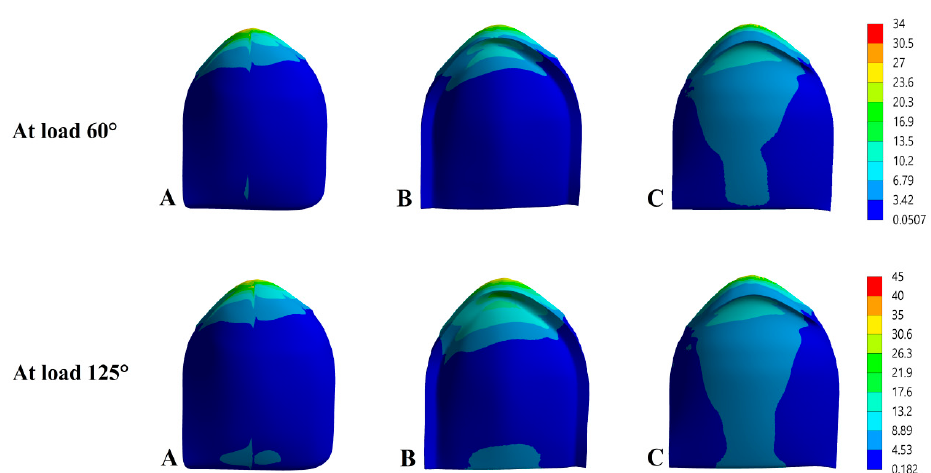
Figure 6. von Mises stress distributions (MPa) in tooth structure. ( A ) Non-preparation design, ( B ) conventional preparation design, and ( C ) proposed preparation design.